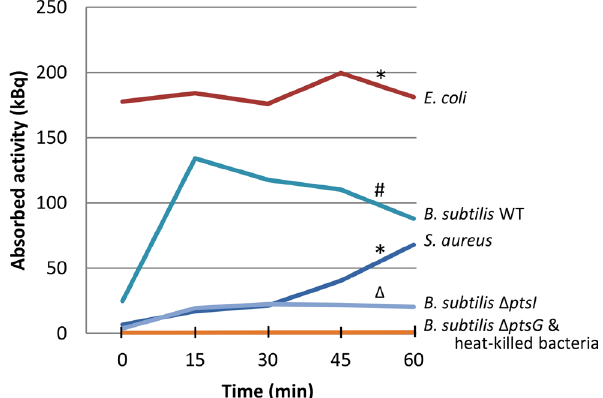
Figure 3. Time course analysis of in vitro uptake of 18 F-FDG. Mean 18 F-FDG uptake was determined over a period of 60 min for clinical isolates of S . aureus (red) and E . coli (dark blue), and for the B . subtilis type strain 168 (light blue) and its ptsG (orange) or ptsI mutant (purple) derivatives. Heat-killed bacteria (orange) served as negative controls. Samples were withdrawn at the indicated time points to assess the 18 F-FDG uptake. * p < 0.01 vs. heat-killed controls; # p < 0.001 vs. both mutants; Δ p < 0.001 vs. the Δ ptsG mutant.